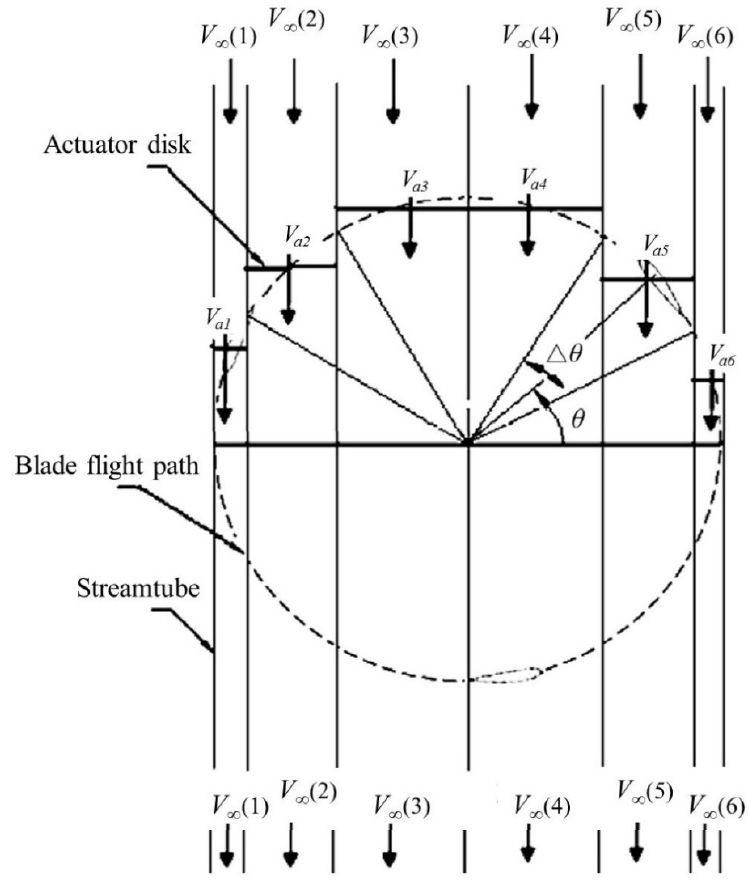
Figure 7. Principle of multiple stream tube model with 6 stream tubes divided by uniform angle Δθ , reprinted with permission from [22]. Copyright 2011 Scientific